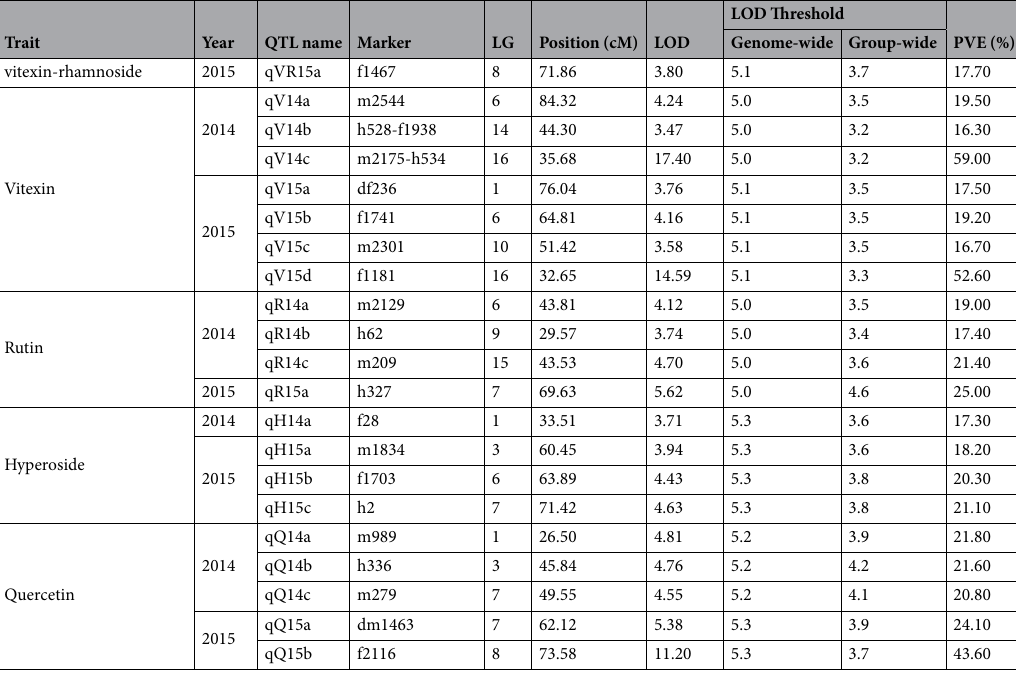
Table 5. All QTLs for 5 flavonoid content-related traits. PVE: phenotypic variance explained.